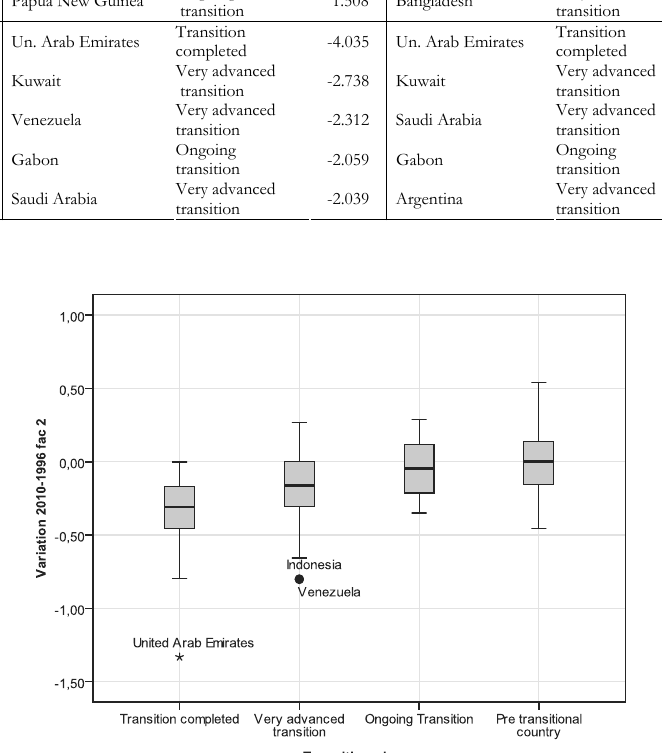
Picture 6 – Score variation 1996-2010 for transition phase Boxplot. Factor